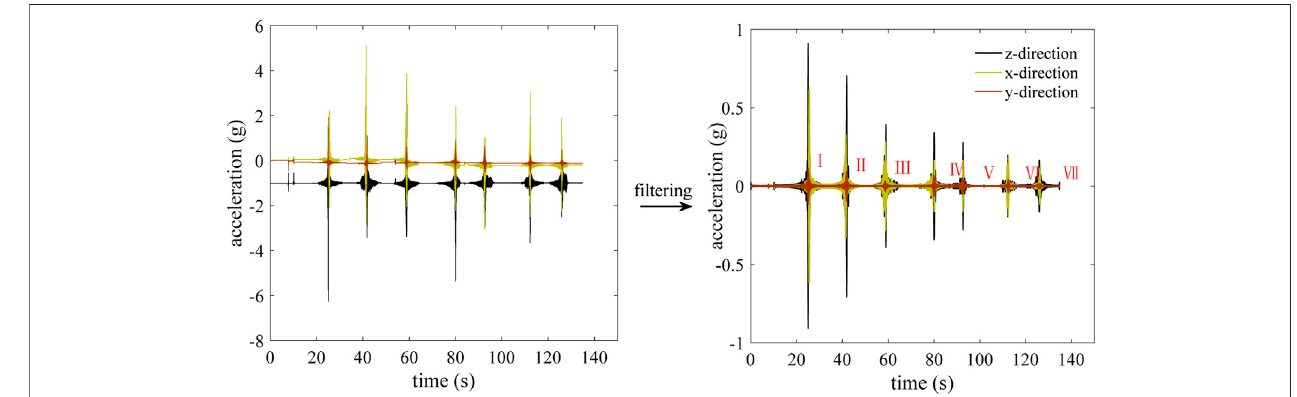
FIGURE 5 | Time histories of acceleration in the fi eld test.